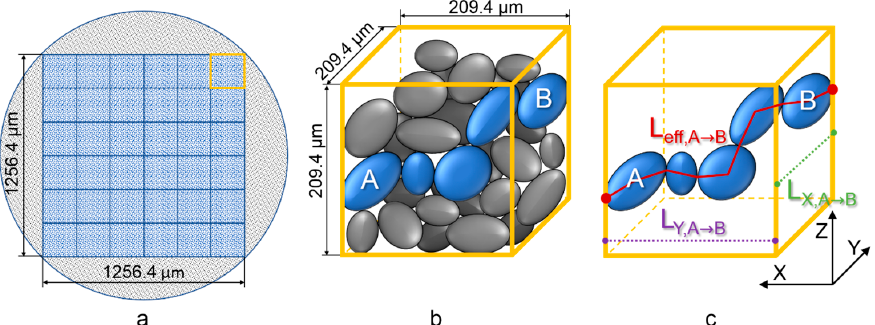
Figure 9. ( a ) Cropping of horizontal slices to squares and dividing the volume into cubes; ( b ) view at showcase cube filled with particles and illustration of the shortest solid path of two particles (A and B); ( c ) illustration of efficient (L eff ) and ideal solid path lengths (L X/Y ) via skeletal contact modeling between the particles in different axes.